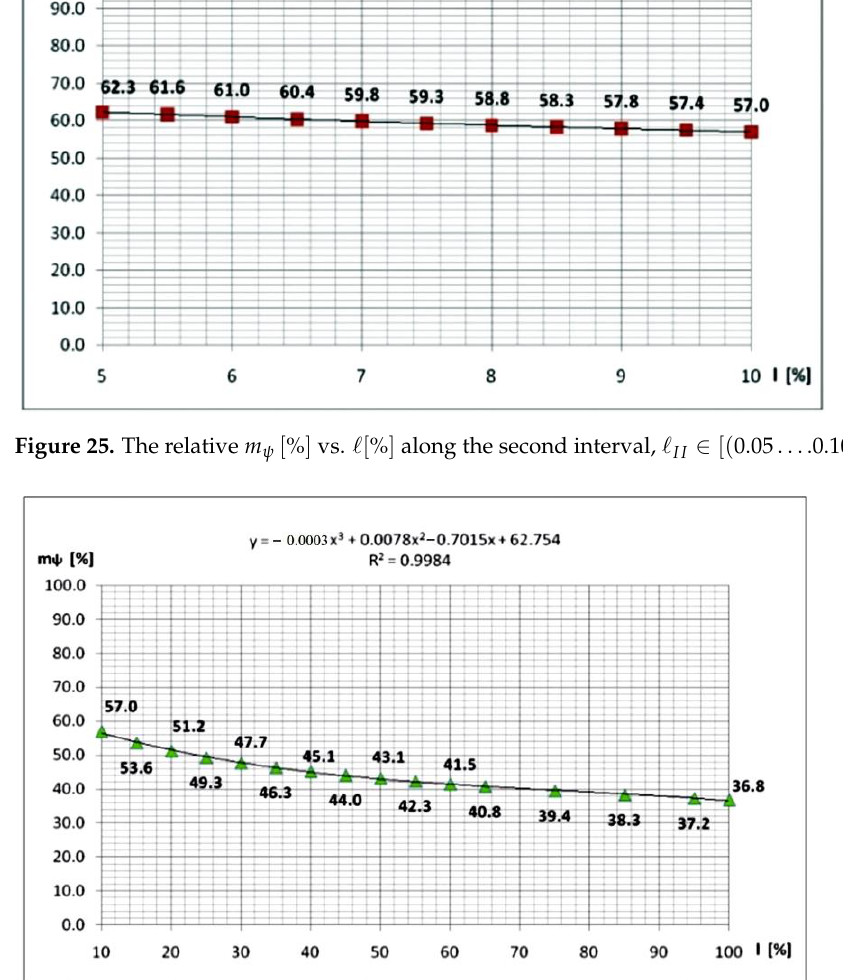
vs. [%] along the third interval, ])......[(